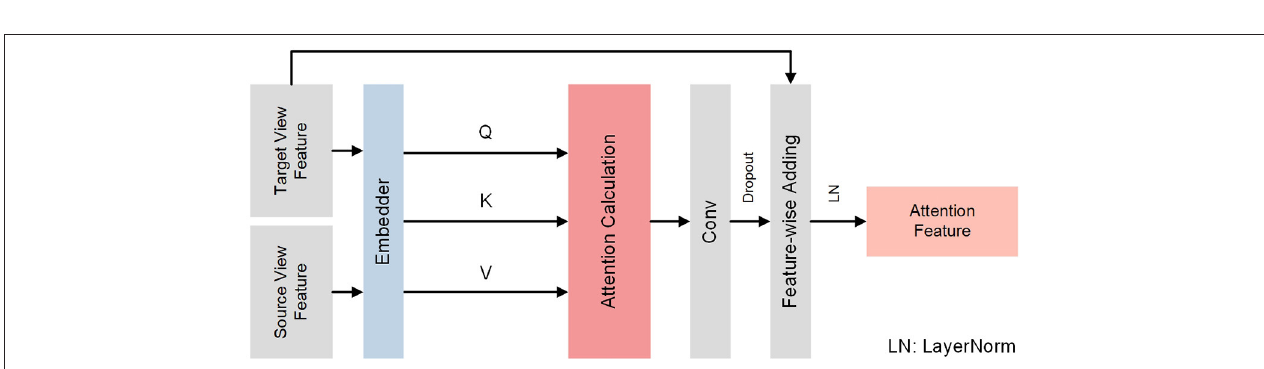
FIGURE 2 | Overall flowchart of the proposed model. The proposed model receives multi-view ultrasound image pairs and biomedical indices of COVID-19 to conduct severity assessment tasks. The proposed reciprocal attention module tackles the multi-view ultrasound data and the proposed biomedical transform module tackles the biomedical data.